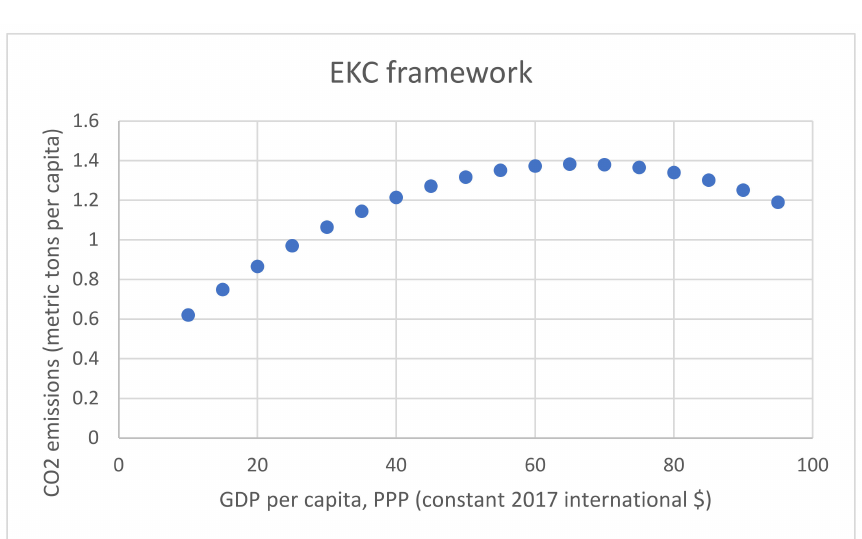
Figure 3. GDP per capita and logged CO 2